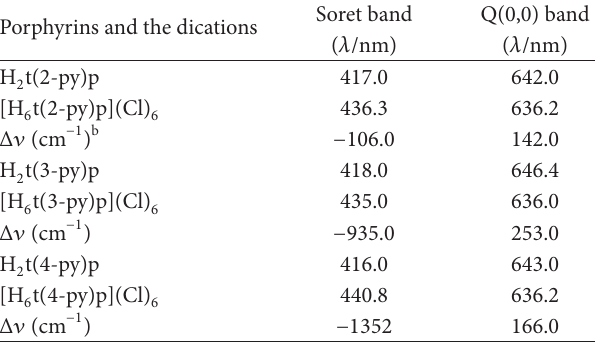
orbitals of the aryl group g 1